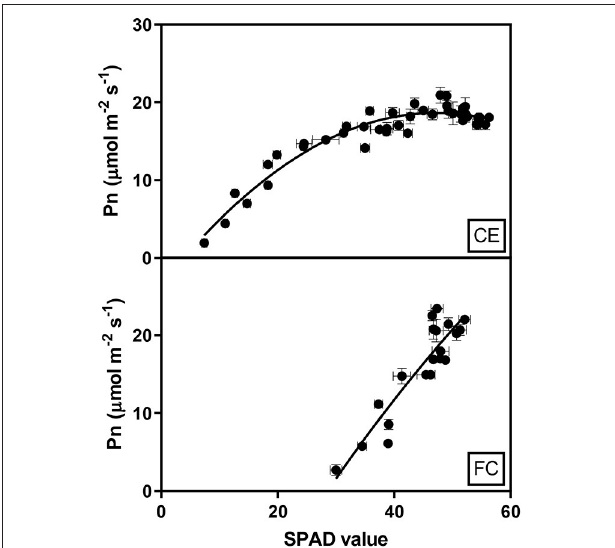
FIGURE 5 | Relationship between the mean net photosynthesis (Pn) and chlorophyll contents (SPAD) of flag leaves in two wheat genotypes (G1, putative heat tolerant and G2, putative heat susceptible) under controlled environment conditions (CE) or heat chambers in the field (FC). Data were combined within an environment due to no significant difference between temperature treatments and genotypes ( p > 0.05). Error bars represent SEM. The equation fit to the CE data is Pn = − 3.38 + 0.93SPAD-0.01SPAD 2 and the equation for FC data is Pn =